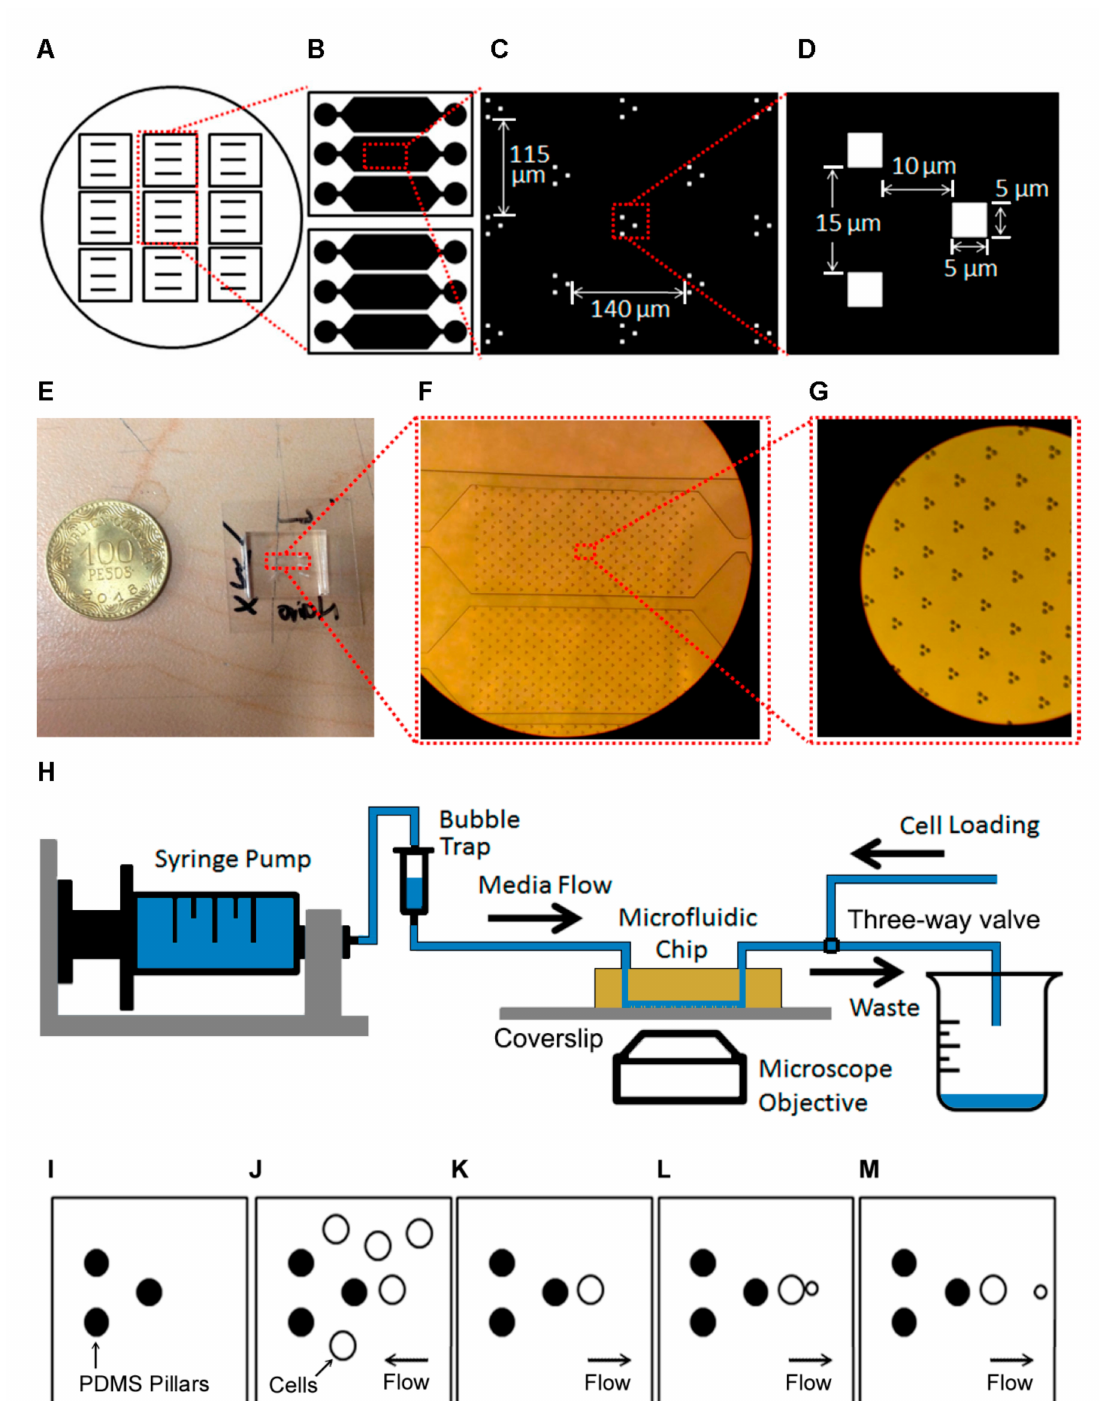
Figure 1. ( A ) The circle represents a silicon wafer with masters for multiple devices. ( B ) Design of each chip, each with three independent channels. ( C ) Individual traps within a channel. We show the vertical and horizontal separations of each of the traps. ( D ) Individual trap dimensions. ( E ). Actual Microfluidic Chip compared with a Colombian Coin. ( F ) Zoom-in of the channels. ( G ) Zoom-in of the pillars. ( H ) Sketch of the experimental setup. ( I – M ) Sketch of trap operation. ( I ) Empty trap. ( J ) Concentrated cells are inserted through the outlet. ( K ) Normal flow is started, and only cells that are in the trapping area remain. ( L ) Cells grow and reproduce. The flow directs budding cells to the right. ( M ) When the daughters detach, the flow takes them